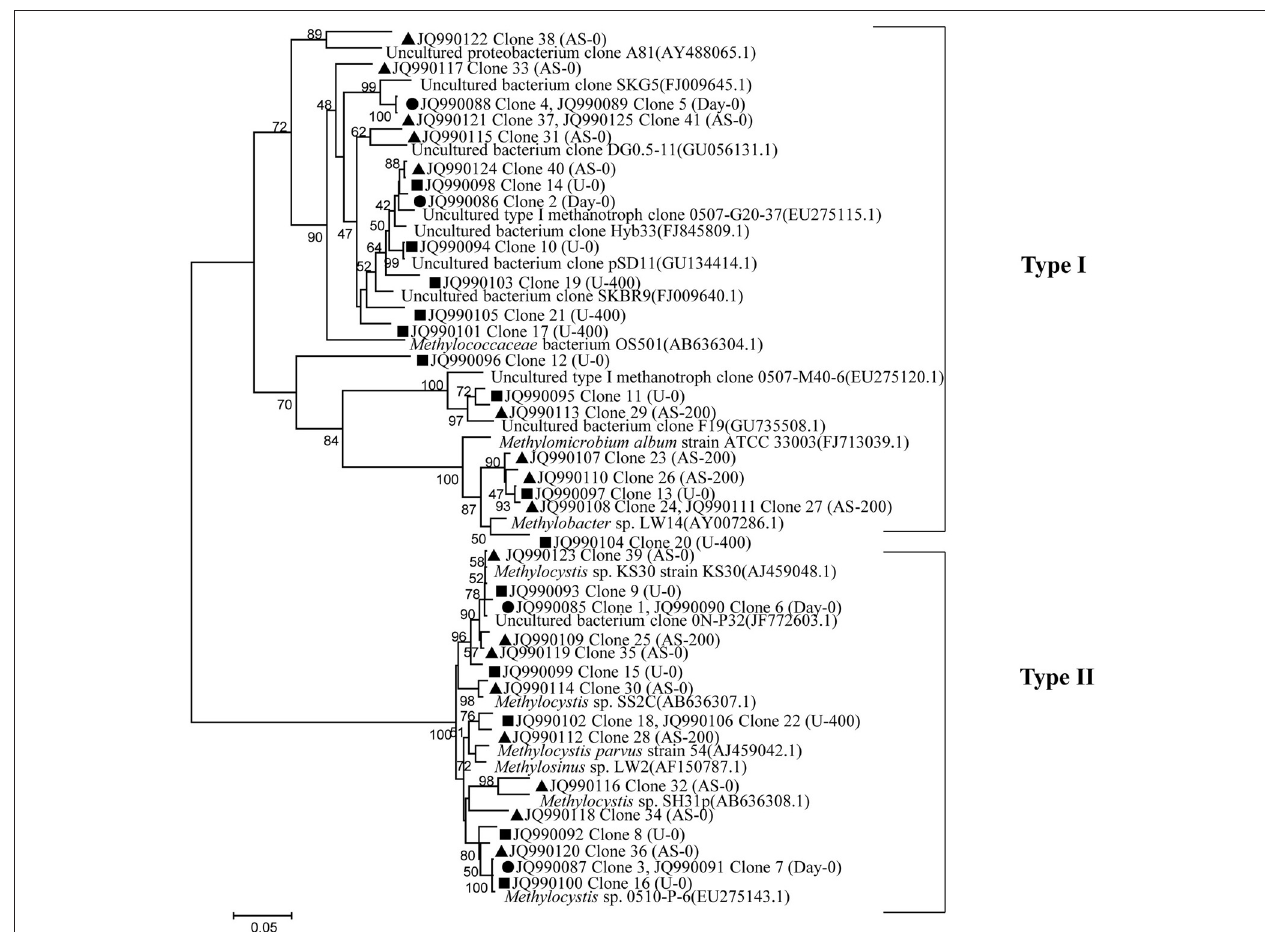
FIGURE 4 | Neighbor-joining tree showing the relationships of the pmoA genes retrieved from the clone library in this study to those in GenBank. The scale bar indicates 5 changes per 100 nucleotide positions. Bootstrap